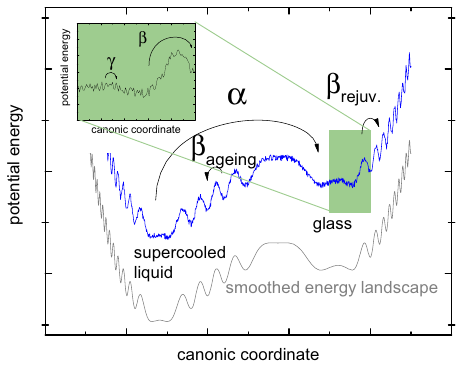
Fig. 8 Potential energy landscape scheme. Schematic representation of the energetic scales of the relevant dynamic relaxation modes at a constant temperature T < T g . Table 2 Sample matrix showing the number of HPT rotations, deformation temperature ( T def. ) and storage temperature for all sample treatments T stor. .